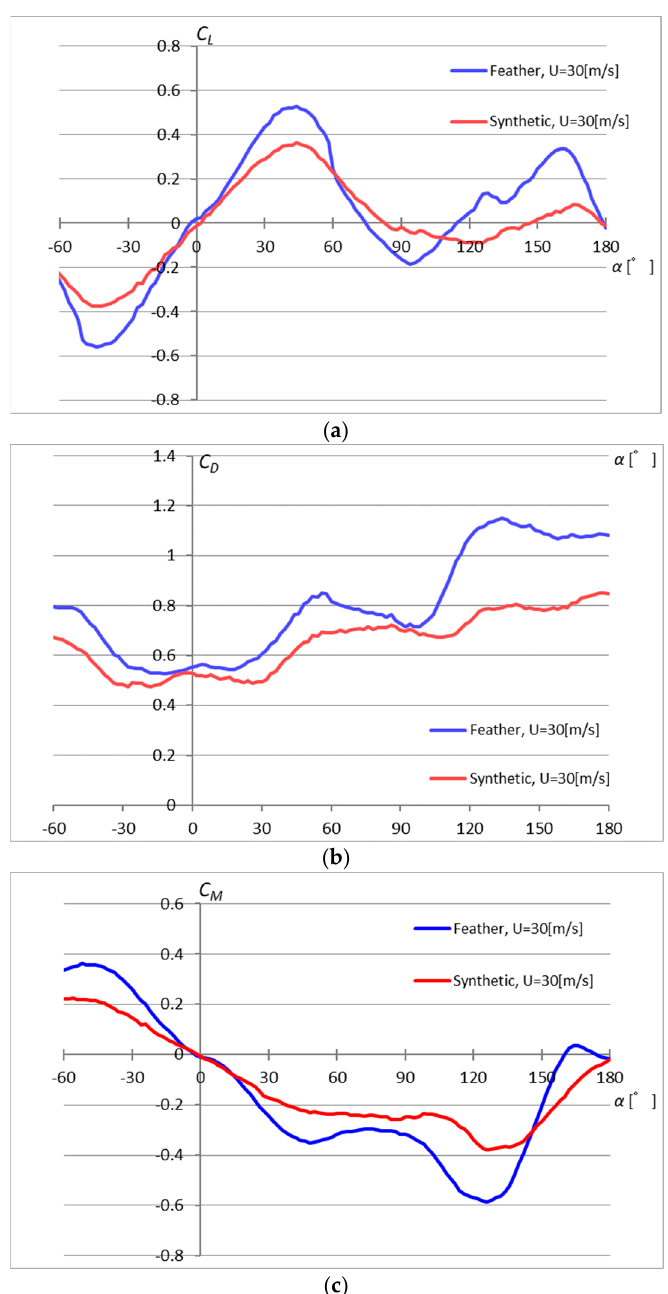
Figure 4. Aerodynamic coefficients of the feather shuttlecock and the synthetic shuttlecock as a function of the angle of attack at U 0 = 30 m/s ( Re = 1.3 × 10 5 ). ( a ) Lift coefficient curves , ( b ) drag coefficient curves , and (c) pitching moment coefficient curves